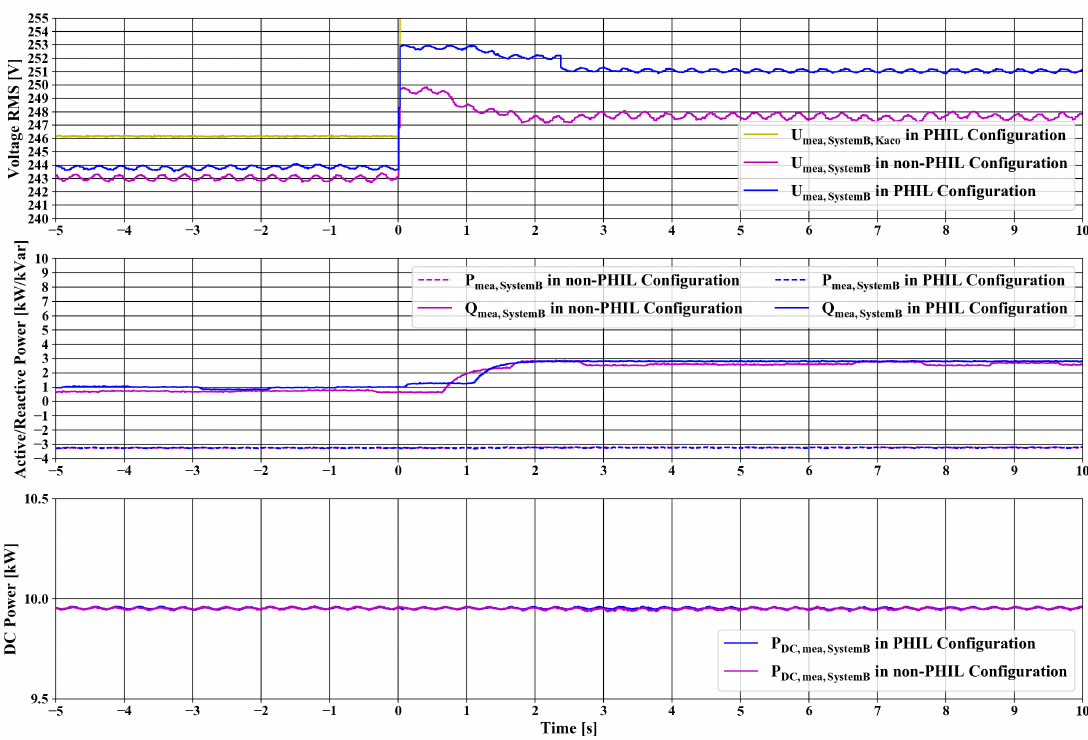
Figure 7. Comparison of the different system responses to the deviation voltage step. The est compared a non-PHIL setup with a real impedance to the PHIL setup with emulation of this impedance. The depicted values are RMS-values calculated on a one-period time frame. The DC-power is also